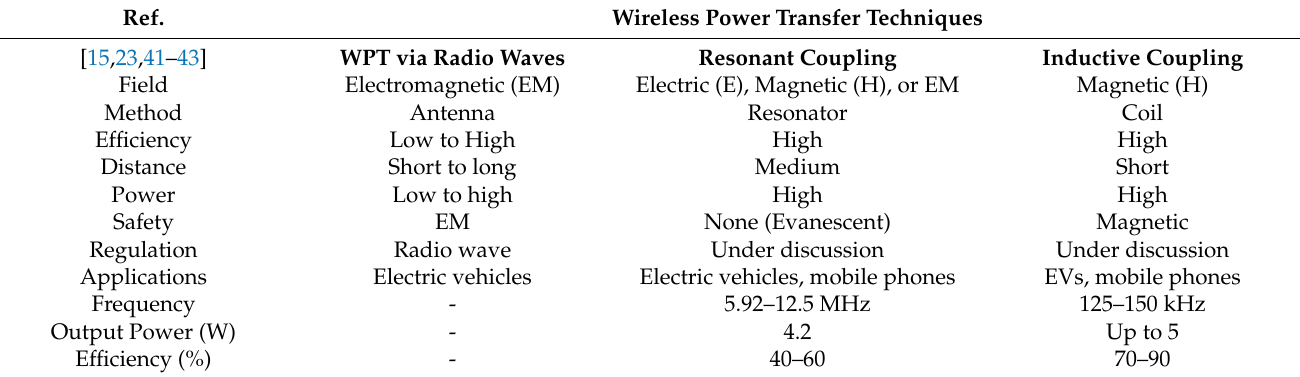
Table 3. Characteristics of wireless power